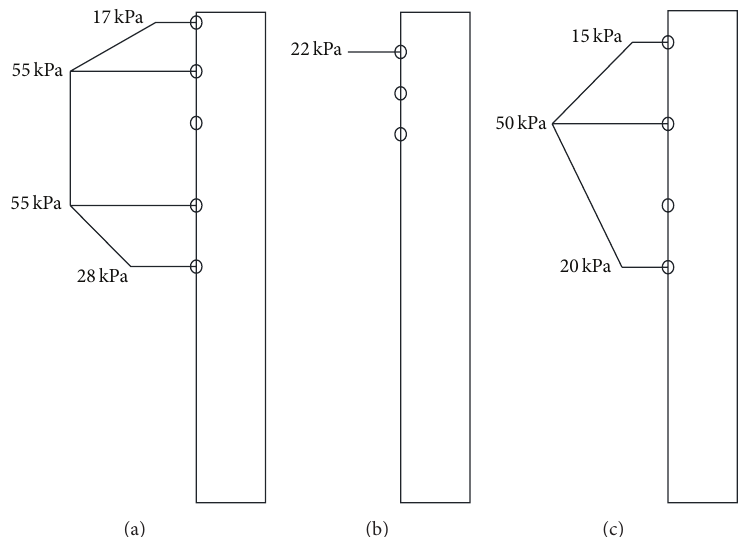
Figure 12: Measurement results of pressure between landfills and antislide piles: (a) 2 # antislide pile; (b) 4 # antislide pile; (c) 6 # antislide